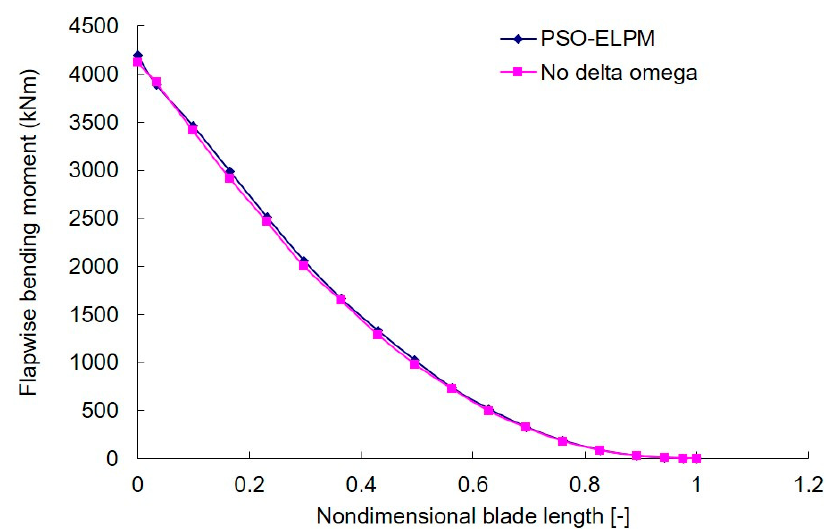
Figure 13. Comparison of extreme edgewise bending moment along the blade (2.0 MW).